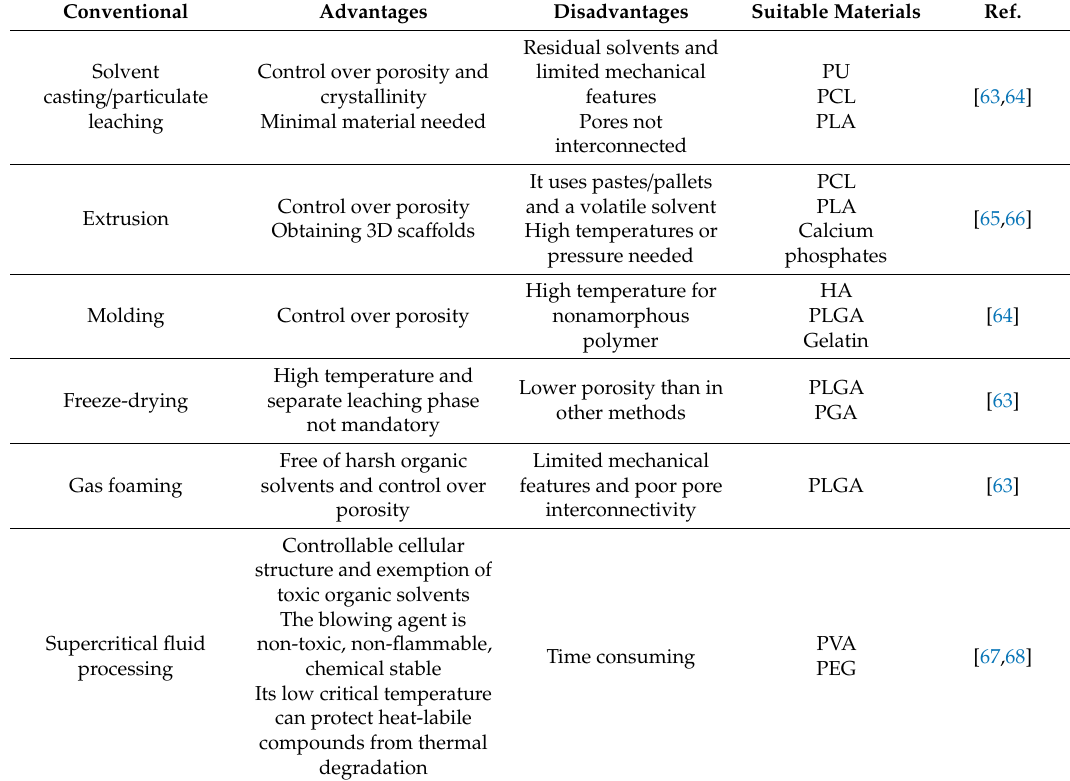
Table 5. The Most Commonly Used Methods for the Fabrication of Sca ff